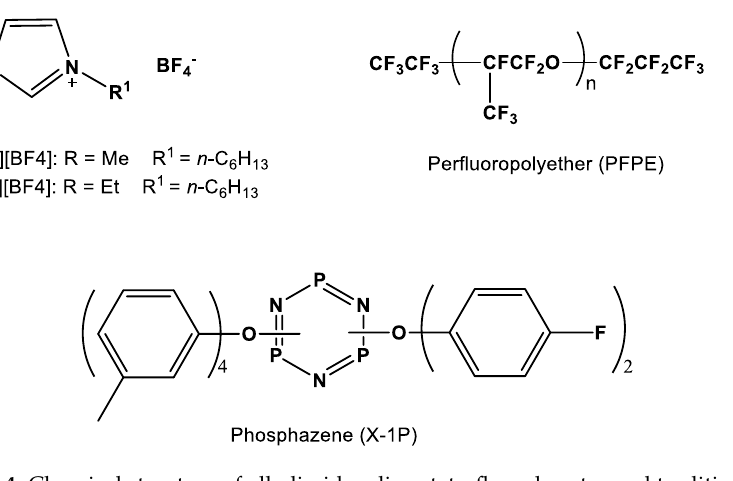
Table 1. Friction coefficients for various sliding pairs lubricated with some lubricants (load 50 N, frequency 25 Hz, amplitude 1